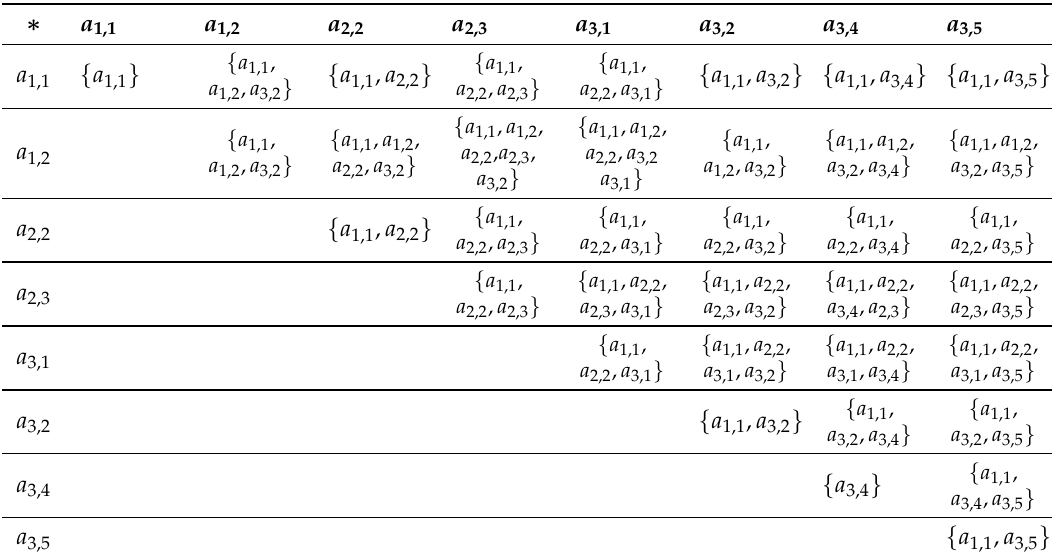
Table 2. The hypercomposition table of ( H , ∗ )